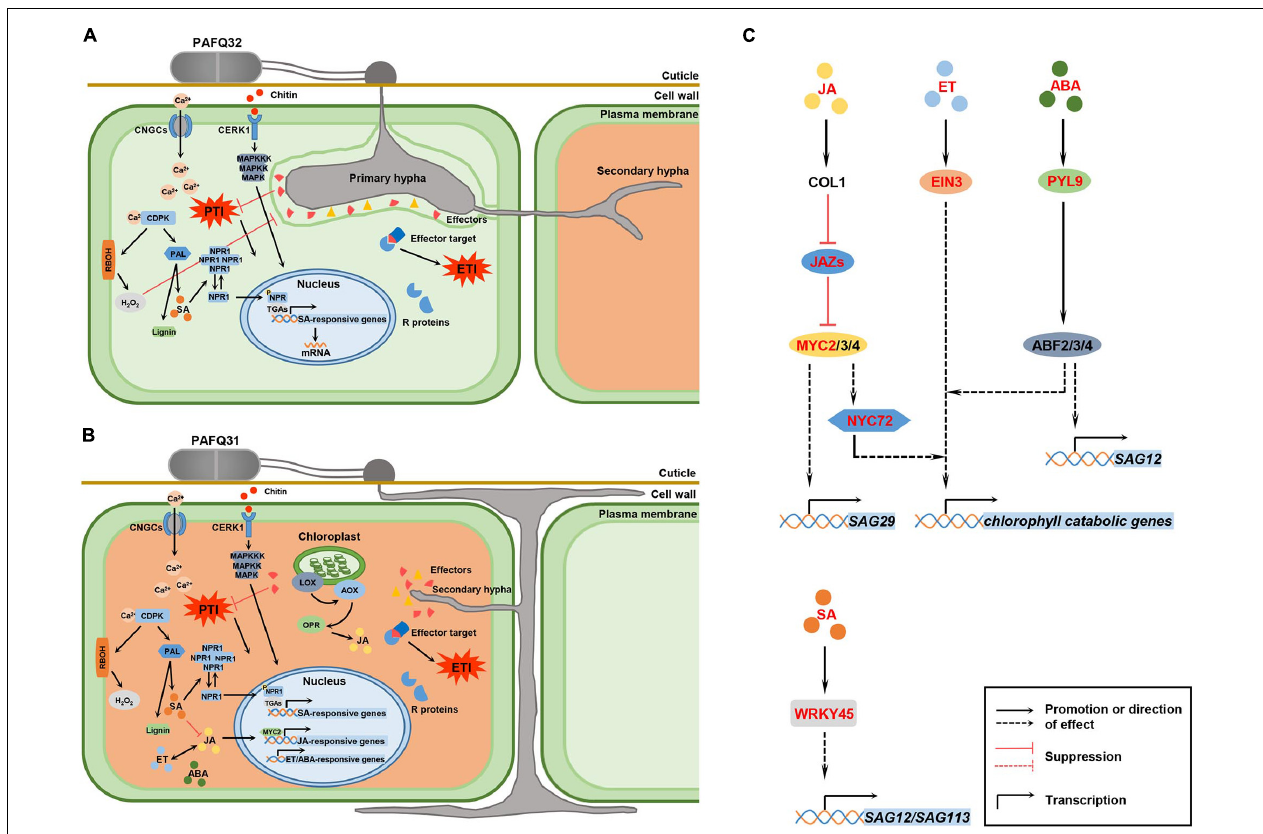
FIGURE 9 | Hypothetical model for P. pyrifolia in response to the infection of two pathogenetic C. fructicola strains and the crosstalk between hormone signaling and transcription factors (TFs) that are involved in leaf senescence. (A,B) Proposed models for P. pyrifolia in response to the infection of strain PAFQ32 and PAFQ31, respectively. In panel (A) , (1) After infection by strain PAFQ32, pear plants sense fungal pathogen-associated molecular patterns (PAMPs) (exemplified by chitin) with host pattern recognition receptors, and produce a variety of defense responses including activation of the mitogen-activated protein kinases (MAPKs) and plant hormones signal transduction pathway, change of intracellular Ca 2 + concentration, and production of reactive oxygen species (ROS); (2) The fungus further secrets multiple effectors to target host proteins and suppress pathogen-associated molecular patterns (PAMPs)-triggered immunity (PTI); (3) The plants synthesize resistance (R) proteins to recognize effector activity that triggered strong effector-triggered immune responses; (4) SA may act a pivotal role in the process of PTI or effector-triggered immunity (ETI) activation. In panel (B) , (1) strain PAFQ31 grows under the cuticle within the cell wall around the epidermis and shortly form thin secondary hyphae to destruct the colonized host tissues; (2) The plants active PTI or ETI, and JA, ET, and ABA signaling pathways. (C) Effects of specific phytohormones and TFs on leaf senescence. After PAFQ31 infection, pear plants activated JA, ET, ABA, and SA signaling pathways, which may induce the upregulated expression of senescence-associated genes (SAGs) and chlorophyll catabolic genes, and finally result in defoliation of the diseased leaves. Phytohormone, protein and TFs marked in red indicated that the expression of related genes were upregulated in this study. Solid lines represent well-defined biological processes, and dotted lines represent the information reported in the studies of Arabidopsis thaliana as a reference (Woo et al.,